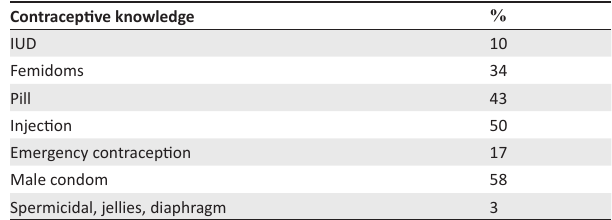
TABLE 1: Contraceptive